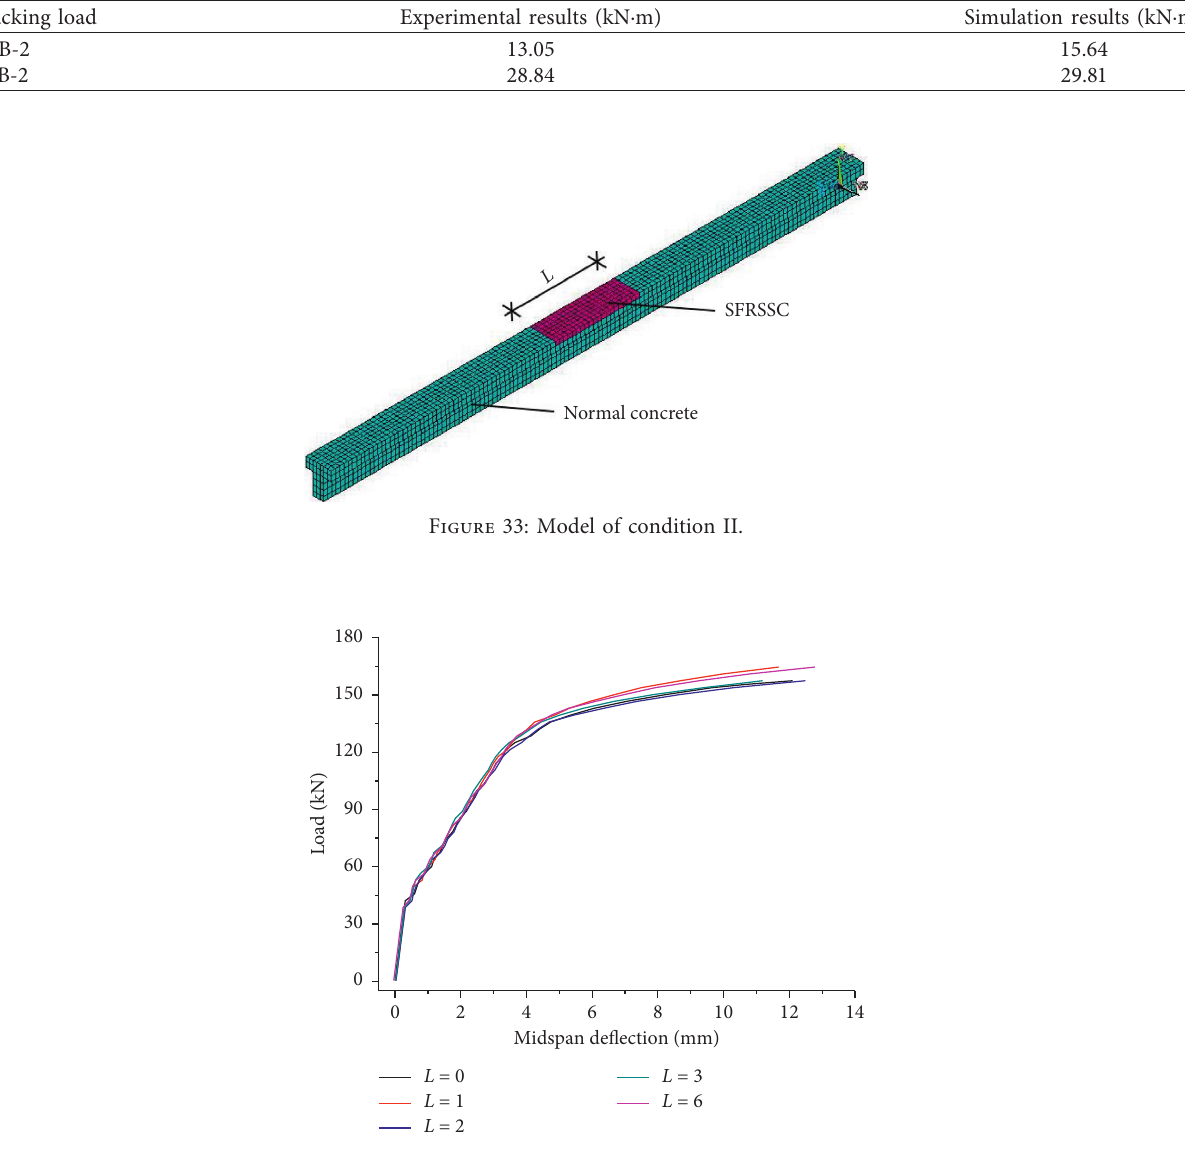
Figure 34: Load-displacement curves for different lengths of the SFRSSC laminated